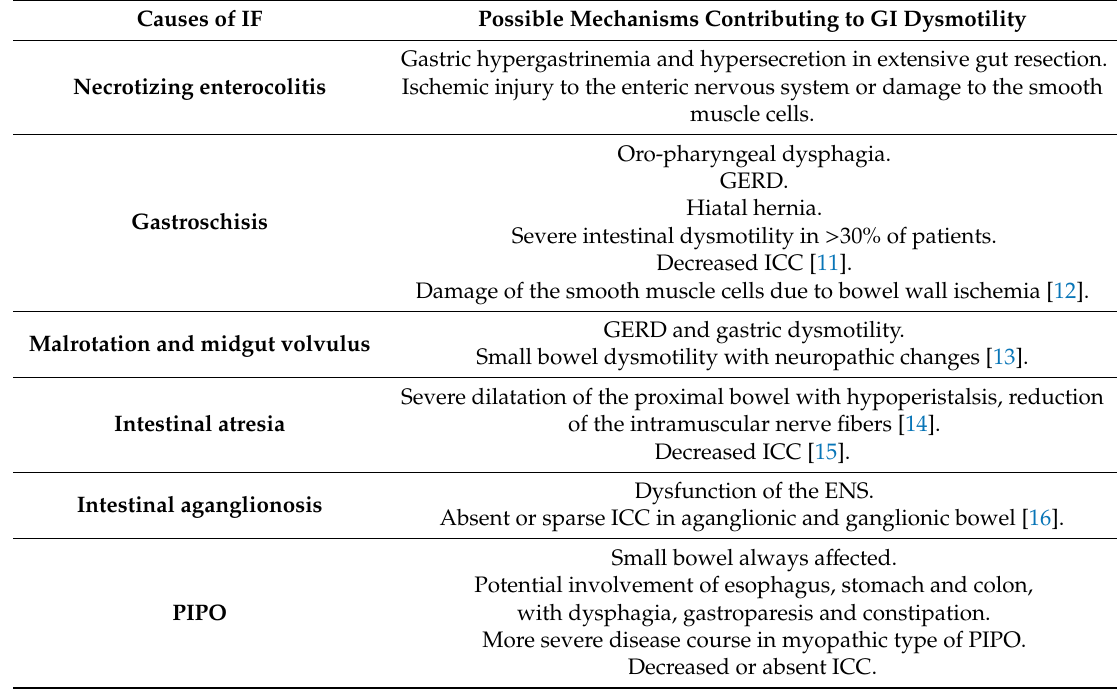
Table 1. Causes of intestinal failure (IF) in children, which impact on gastro-intestinal